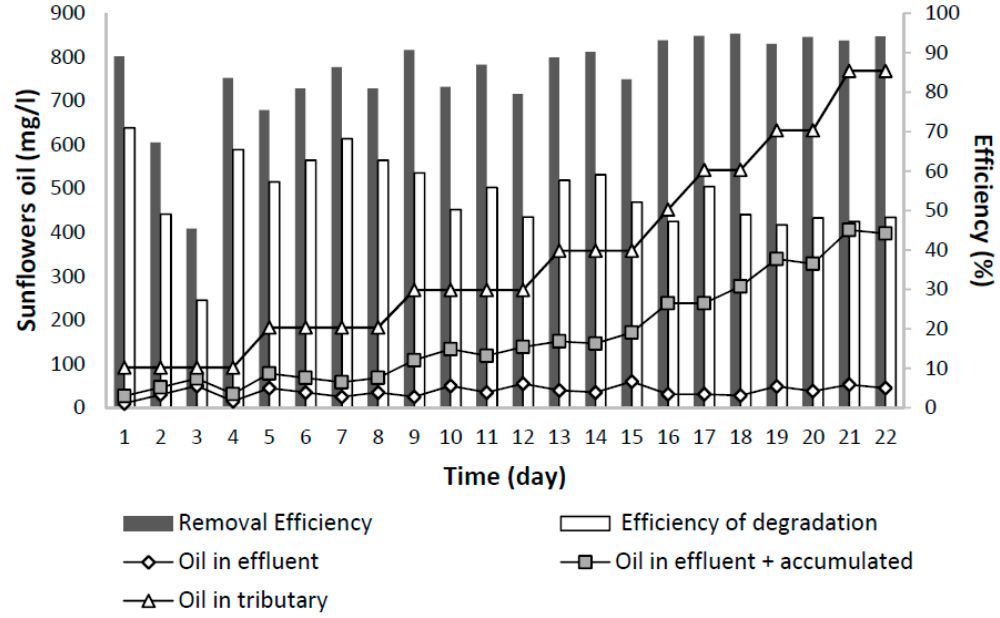
Figure 7. Graphic of the evolution of oil in the influent and effluent, mixed feed, biomass increase, removal efficiency, and biodegradation.